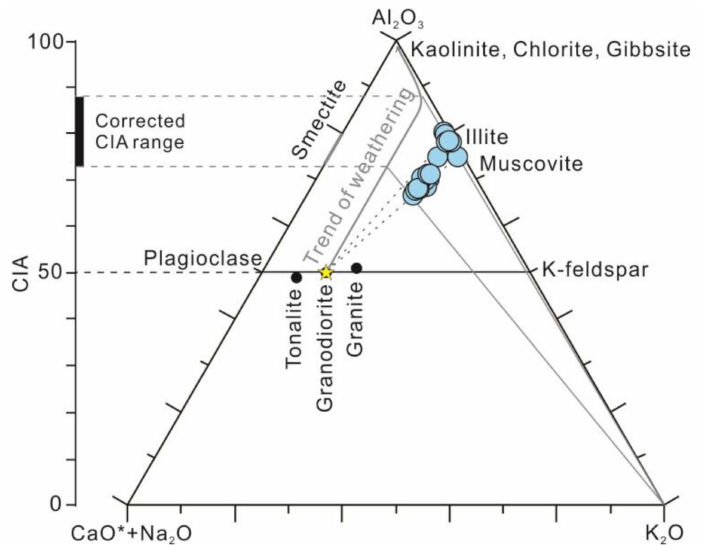
Figure 6. A–CN–K ternary diagram of the samples from the Meiziwan section. Tonalite,